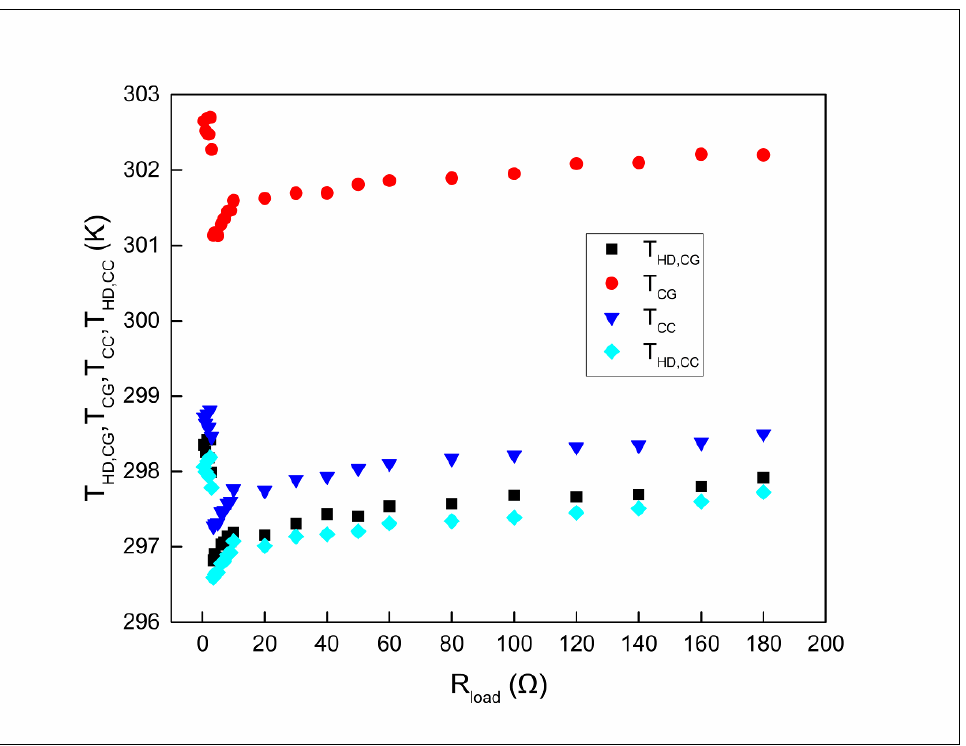
and OUT I is 23.21 mA. The value difference between Figure 9. Dependence of T CG , T CC , T HD,CG and T HD,CC on load resistance. Figure 9. Dependence of CG T , CC T , , HD CG T and , HD CC T on load resistance.